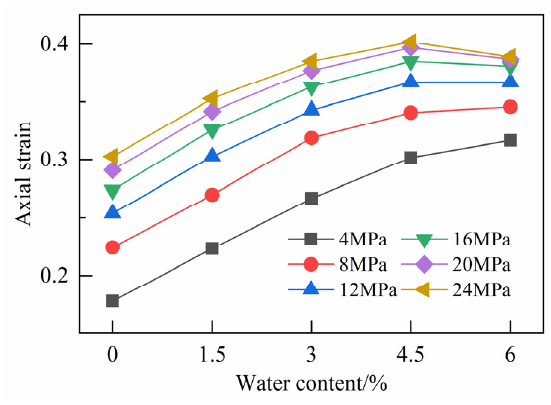
Figure 7. Relationship curves between axial strain and water content.